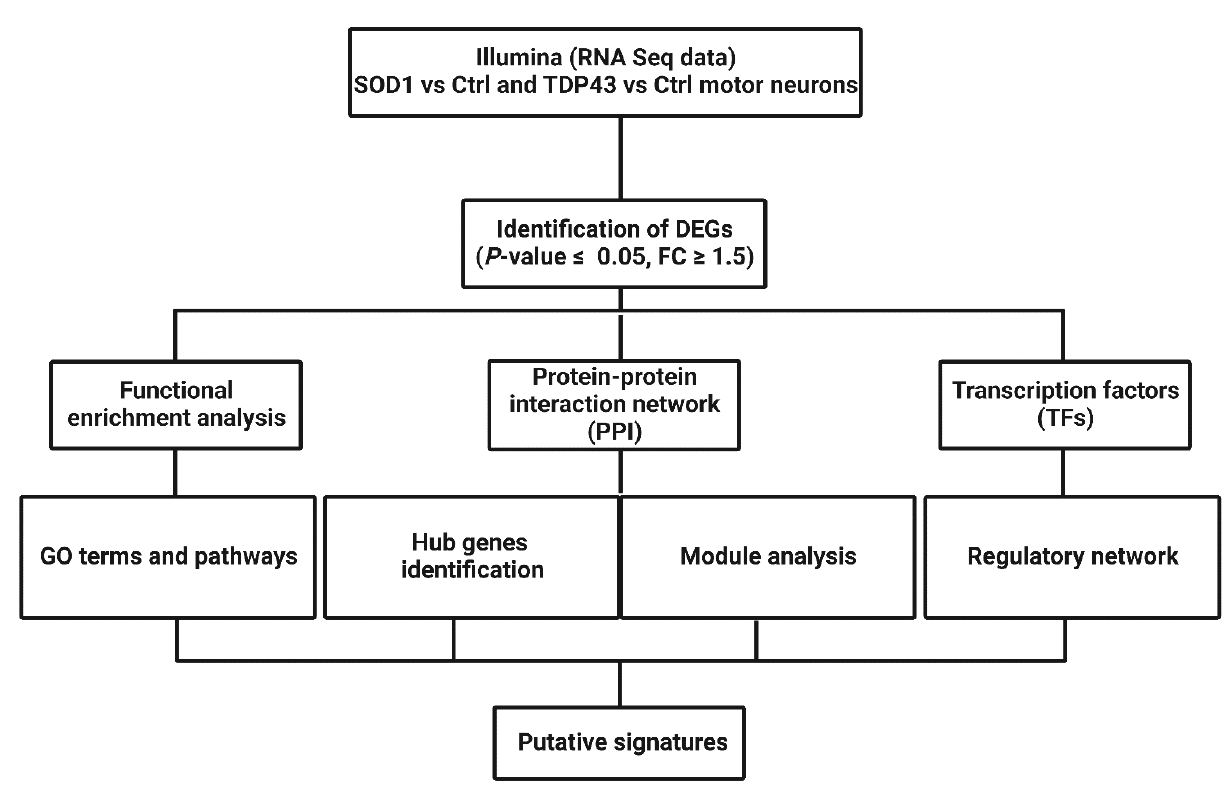
Figure 1. Overall workflow of the study. regulated genes. In TDP43-ALS, 1160 DEGs were found, including 626 upregulated and 534 downregulated genes. The cut-off criteria were set at p -value ≤ 0.05 and | log 2 FC | ≥ 1.5 (FC, fold change). A full list of DEGs is provided in Supplementary Table